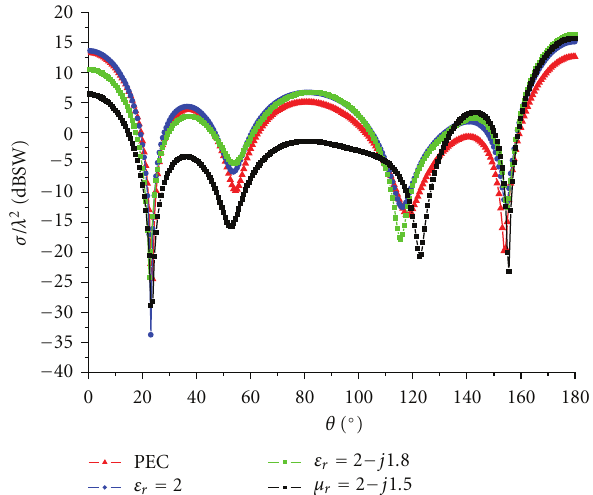
Figure 9: The Bistatic RCS of 3 × 2 array of coating PEC spheres with di ff erent materials.